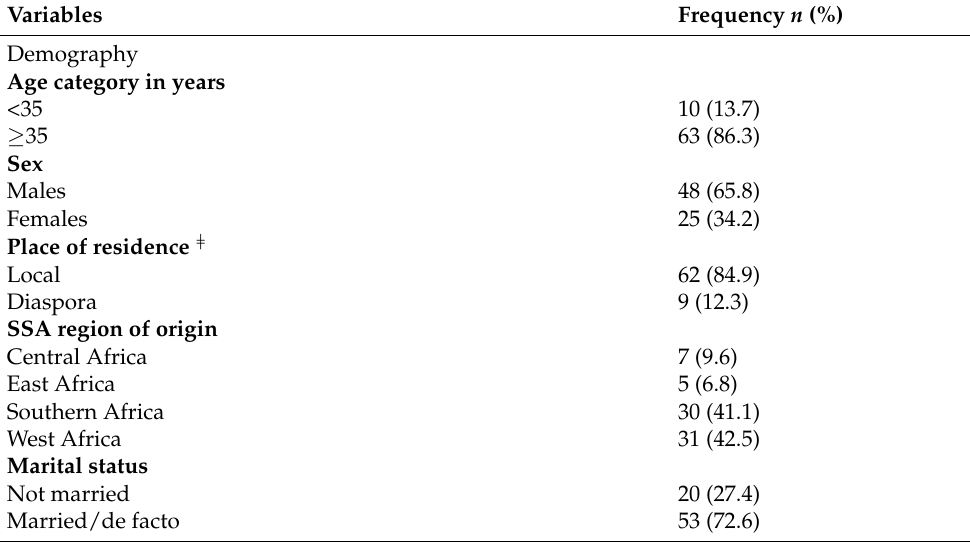
Table 1. Sociodemographic characteristics of study participants ( n = 73).